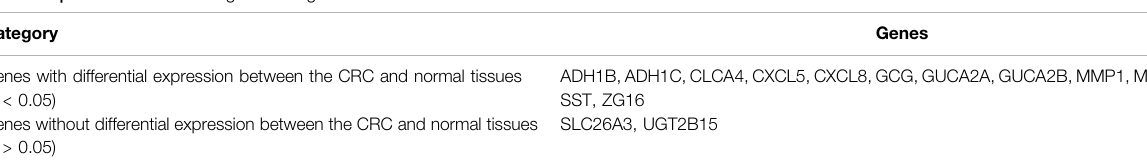
ADH1B,ADH1C,CLCA4,CXCL5, CXCL8,GCG,GUCA2A,GUCA2B,MMP1, MS4A12,PYY, SST, ZG16